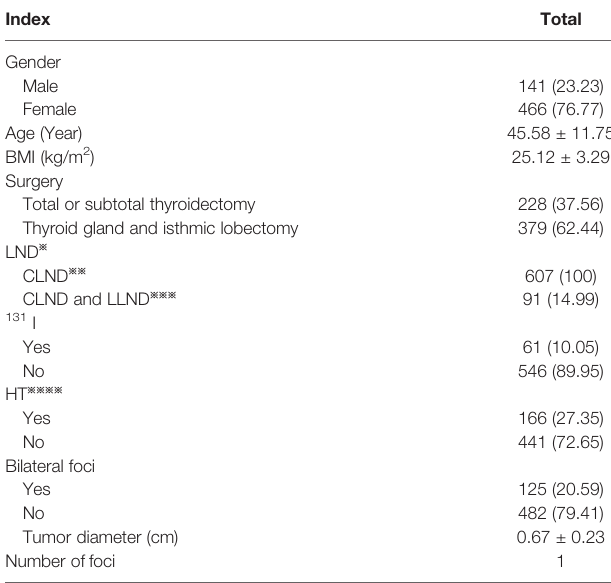
TABLE 1 | Basic information of 607 PTMC